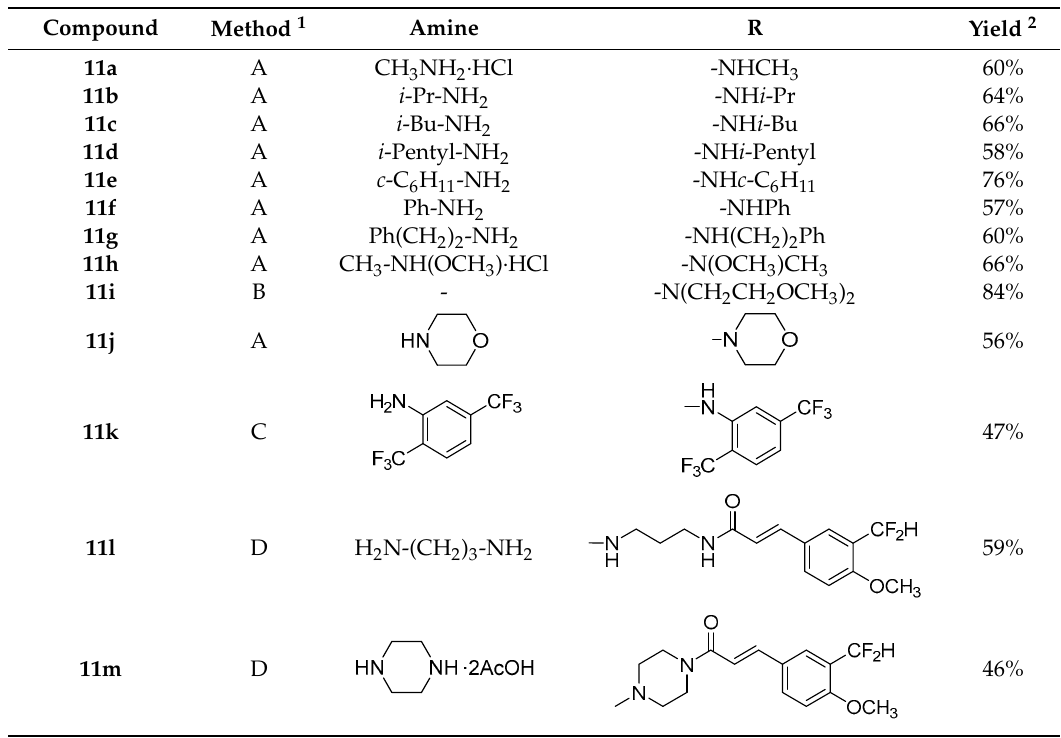
Table 1. Synthesis of 3 ′ -difluoromethyl-4 ′ -methoxycinnamoyl amides 11a – 11m . Compound